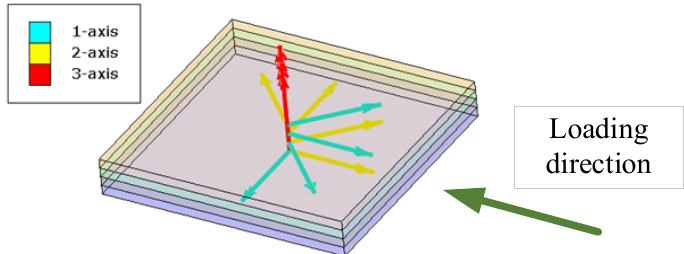
Figure 2. Local orientation for the first four plies.